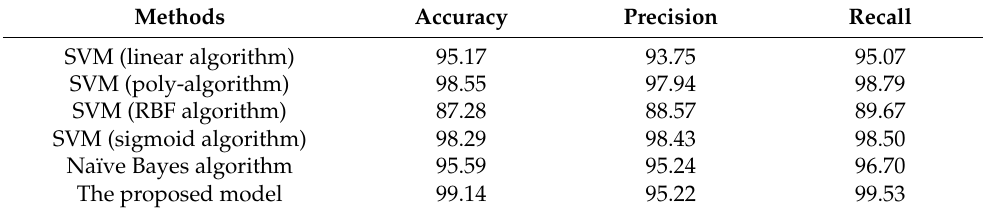
Table 1. A comparative analysis of the AFSA-WELM technique and existing algorithms.